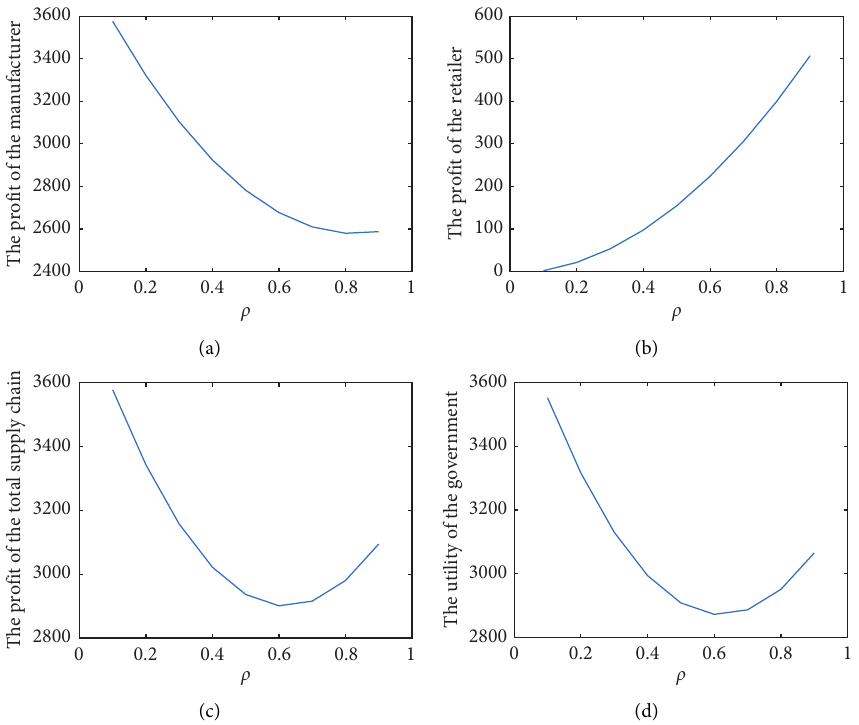
Figure 5: The effect of the degree of consumer preference for the retail channel ρ on profits based on decentralized decision. Table 6: The effect of the government’s subsidy coefficient s